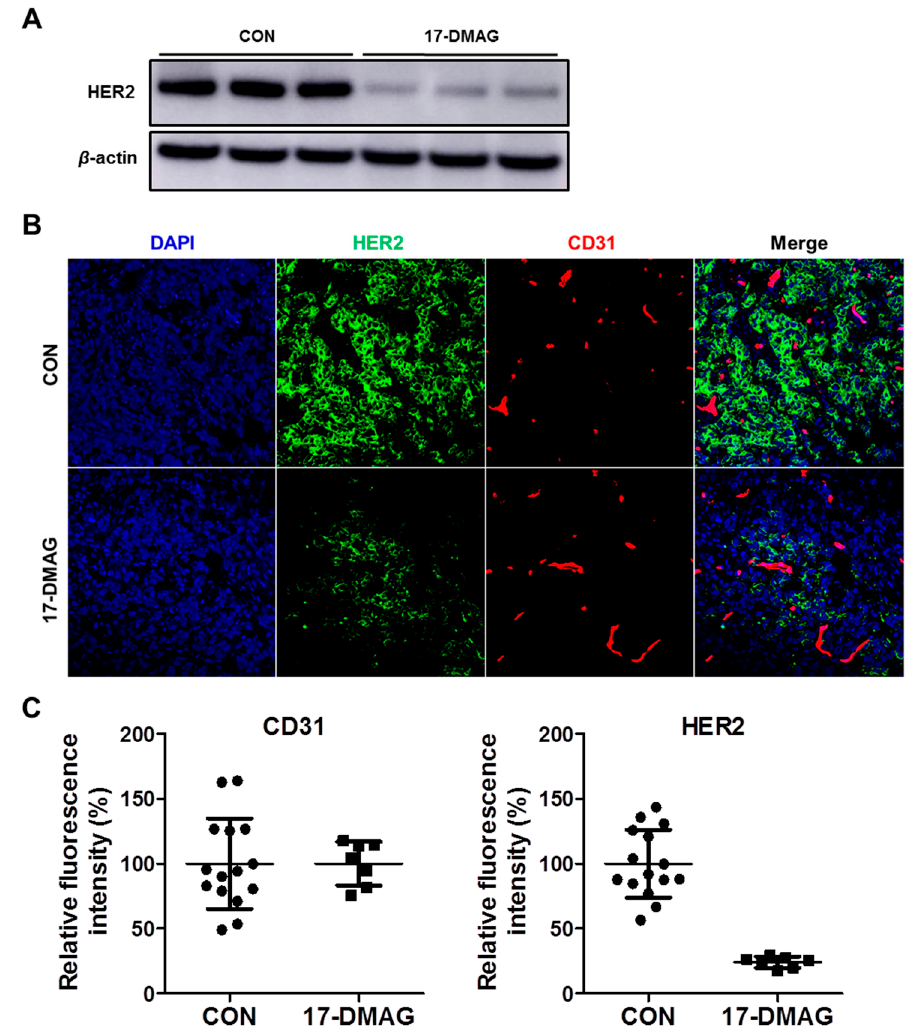
Figure 9. Western blot and immunofluorescence staining in JIMT-1 tumor treated with 17-DMAG. ( A ) Western blot analysis of HER2 expression in JIMT-1 tumor by treatment of 17-DMAG. JIMT-1 tumors were collected 7 days after 17-DMAG treatment. β -actin was used as an internal control. ( B ) Immunofluorescence staining of HER2 in control (CON, vehicle) and 17-DMA- treated JIMT-1 tumor tissues. Frozen section of JIMT-1 tumor was stained with CD31 (red), HER2 (green), and DAPI (blue). Images were acquired at 200× magnification. ( C ) Immunofluorescence staining of HER2 and CD31 was quantified using ImageJ software and quantitative data were expressed as relative fluorescence intensity (%). HER2 relative fluorescence intensity by 17-DMAG treatment was markedly reduced to 25% of control ( p < 0.0001).